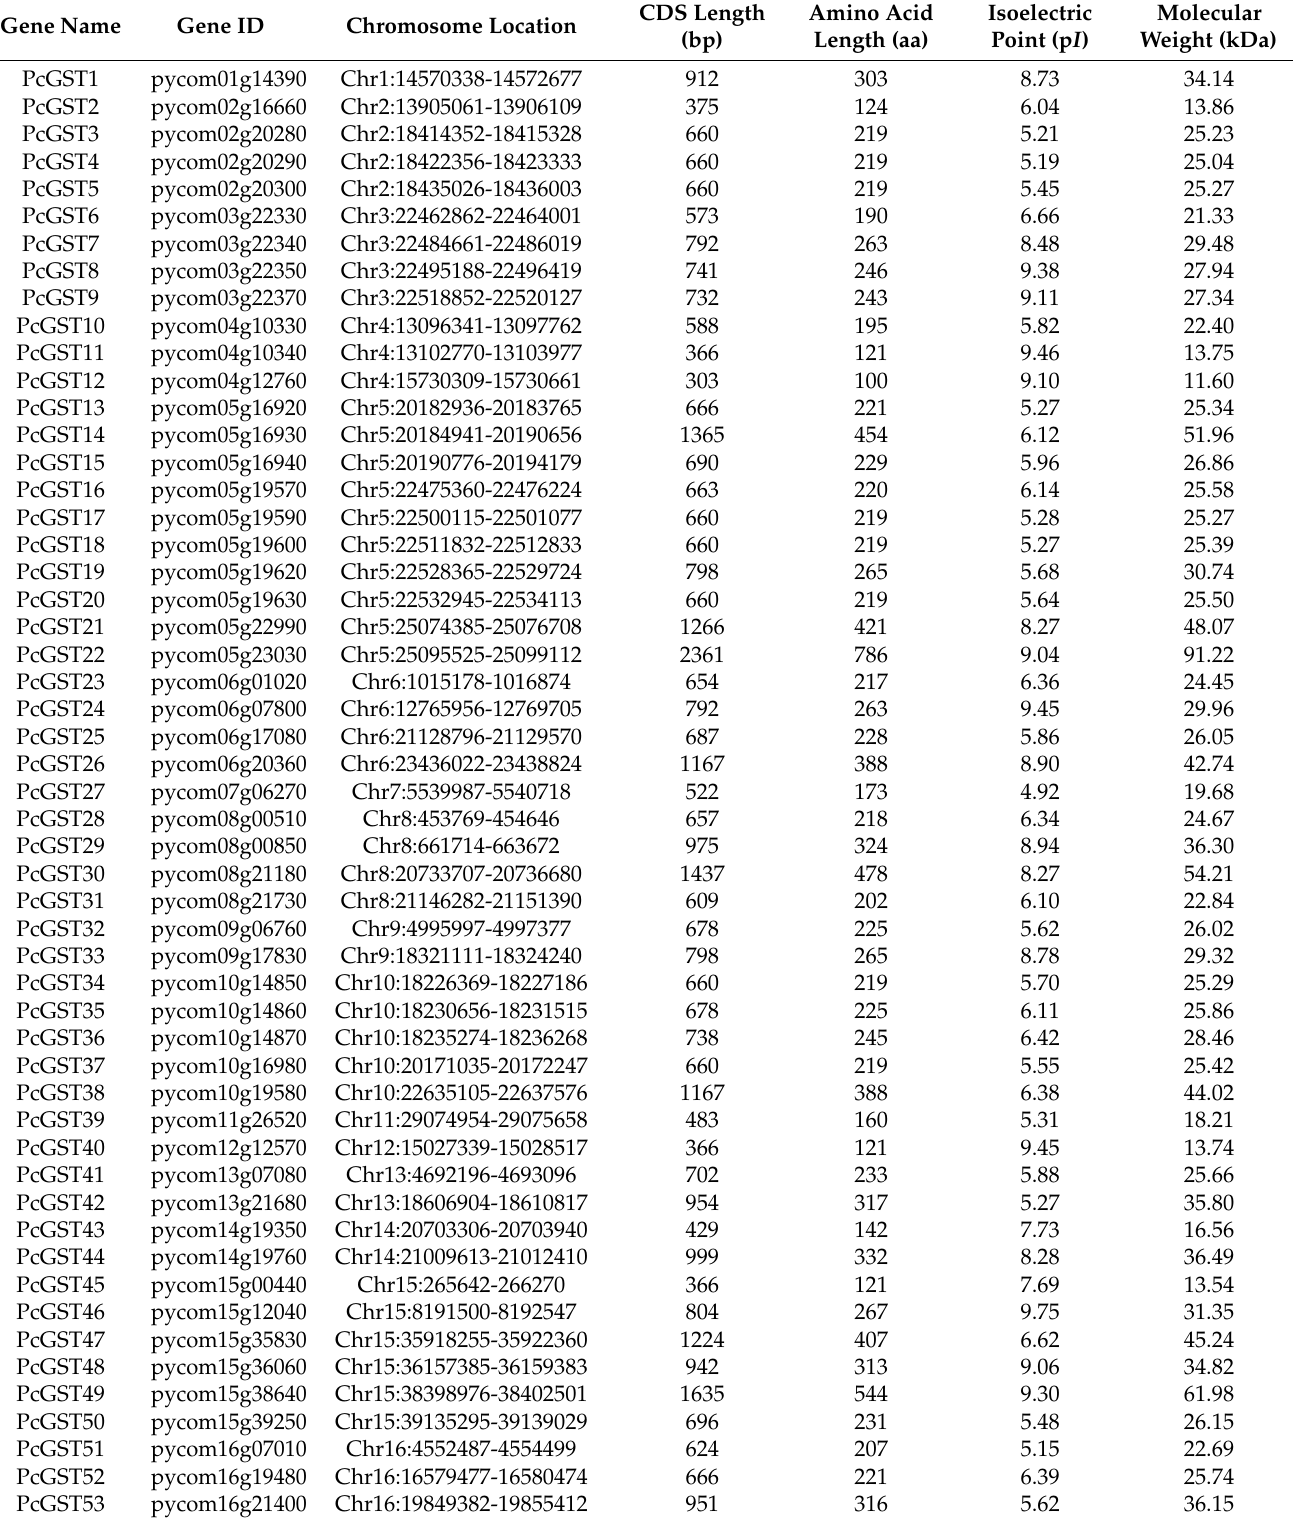
Table 1. Molecular characteristics of the GST family genes identified in the ‘Bartlett’ DH pear